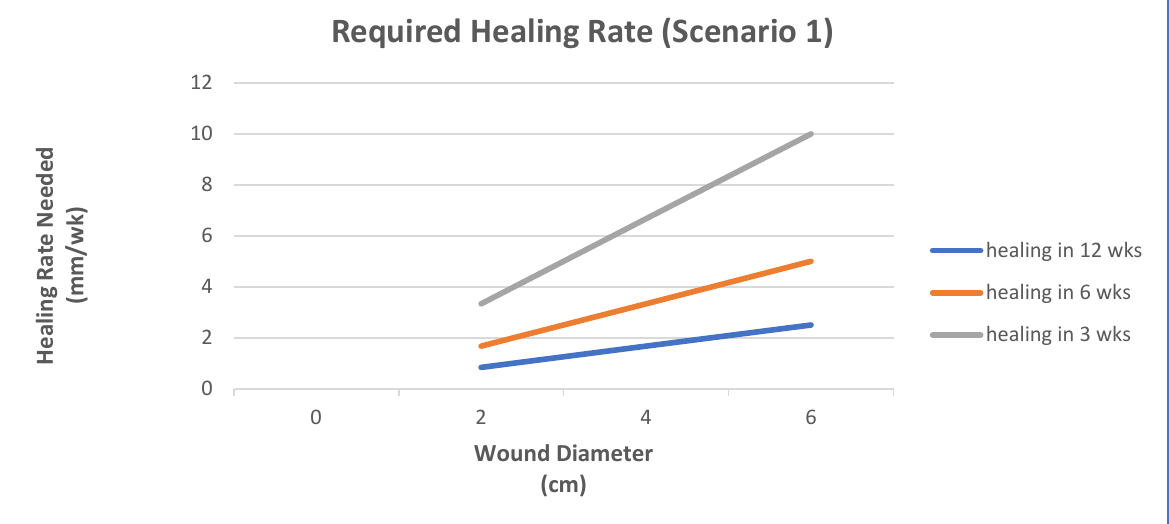
Figure 2. Graph representing healing rate needed if healing is to occur within the specified time for the given wound diameter. This represents scenario 1.